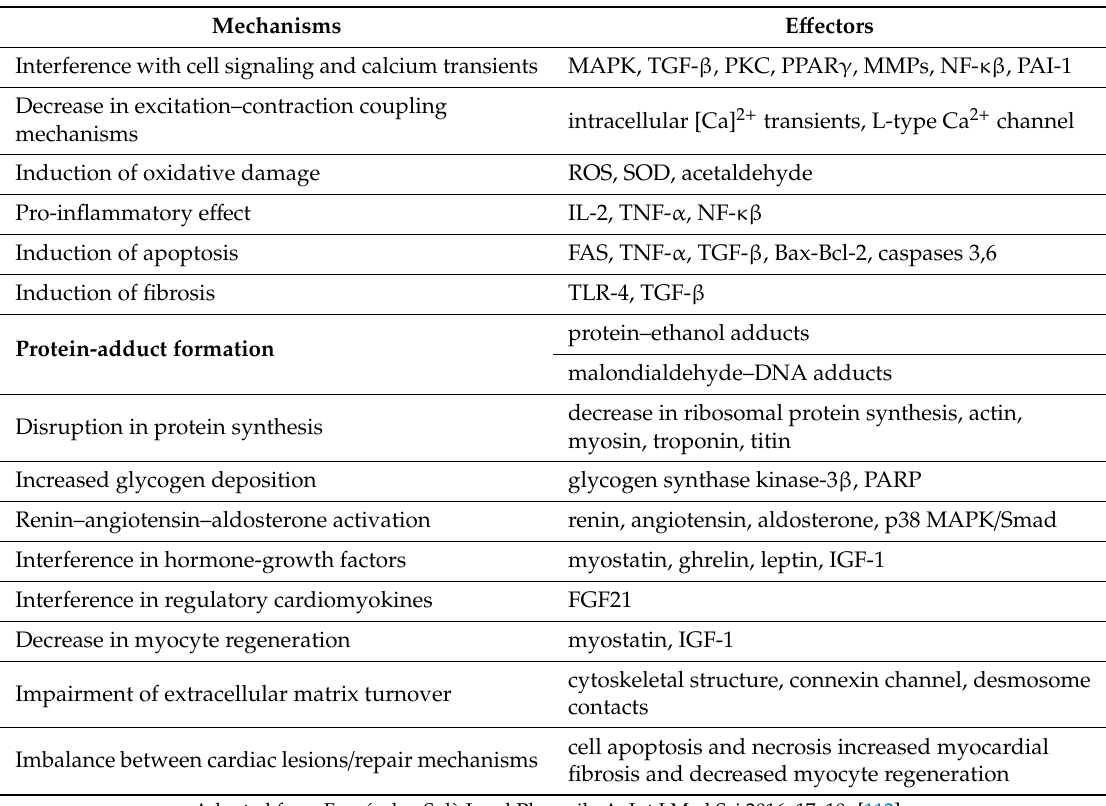
Table 1. Mechanisms of alcohol-induced heart damage and their e ff